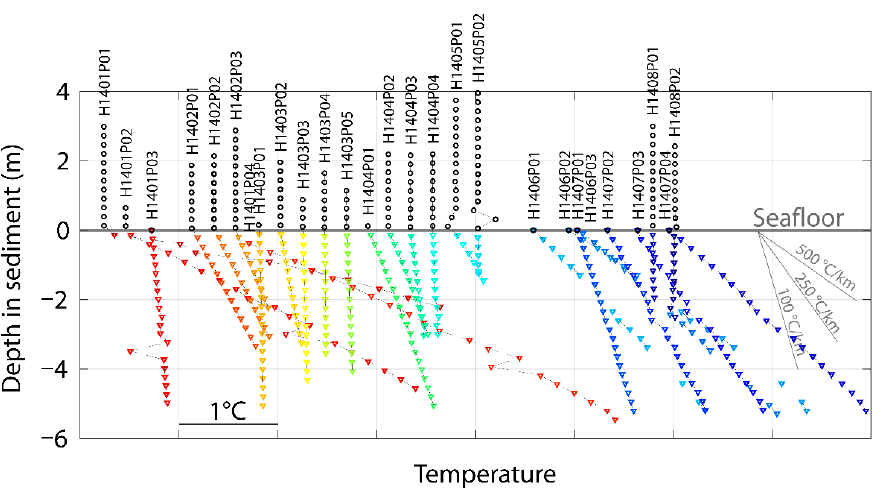
Figure 8. Relative temperature-depth profiles of the thermal investigations during RV Polarstern expedition PS86. Colored triangles indicate sensors that have entered the sediment. Black circles mark sensor readings in the water column above the inferred seafloor location (0 m). All profiles are shown in one figure for inter-comparability. Please note the scale of 1 °C.